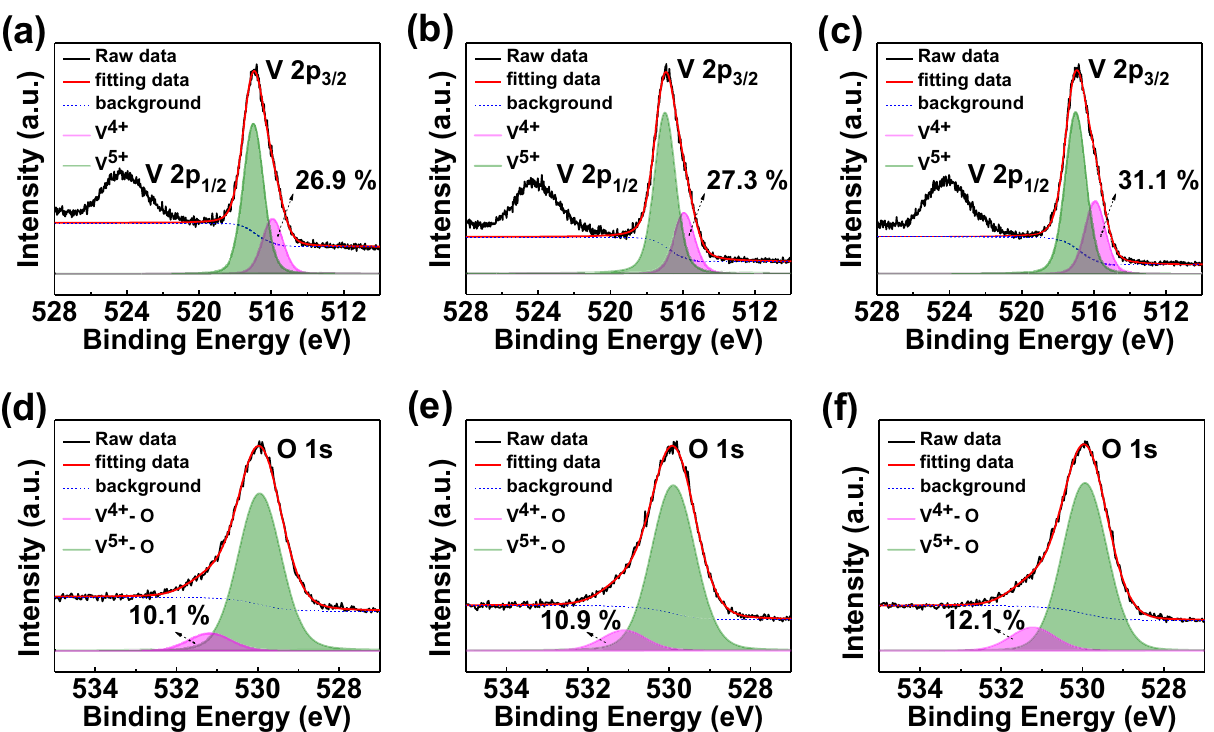
Figure 3. Measured V 2 p 3/2 and O 1 s core level spectra of ( a ), ( d ) 1 wt% V 2 O 5 film on ITO, ( b ), ( e ) 3 wt% V 2 O 5 film on ITO, and ( c ), ( f ) 5 wt% V 2 O 5 film on ITO. In the V 2 p core-level spectra, the ratio of V 4+ and V 5+ are shown, while the ratio of oxygen binding ratio with V 4+ and V 5+ is shown in O 1 s core-level